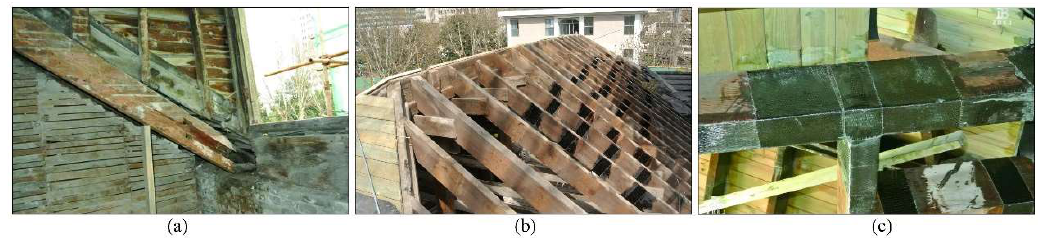
Figure 22. Wood roof truss strengthening (source: author). ( a ) Broken wood roof truss ( b ) Roof truss strengthening ( c ) Roof truss joints strengthening